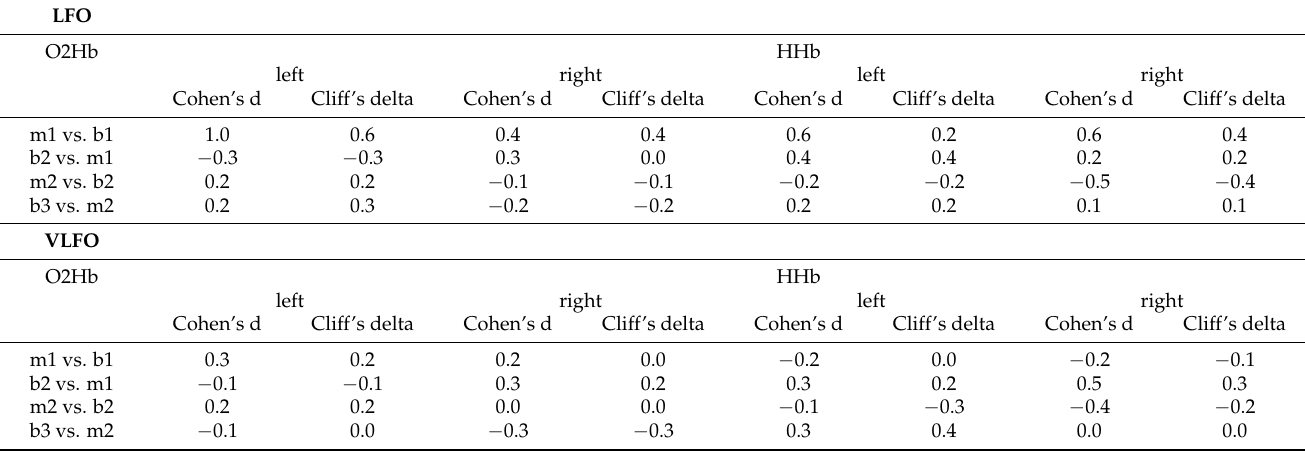
Table 2. Effect size measures (Cohen’s d and Cliff’s delta) for LFO (top) and VLFO (bottom)